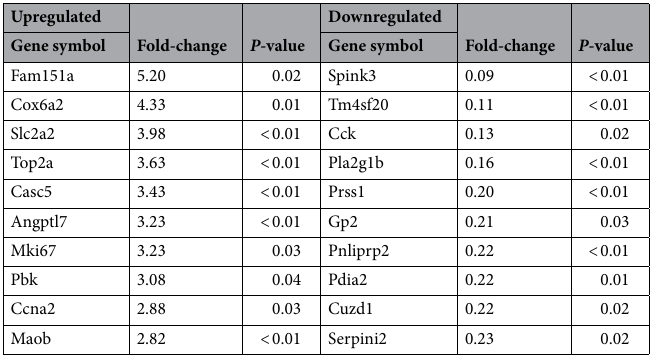
Table 1. Top 10 up- and downregulated genes in the luseogliflozin-treated group. P values were determined using Student’s t